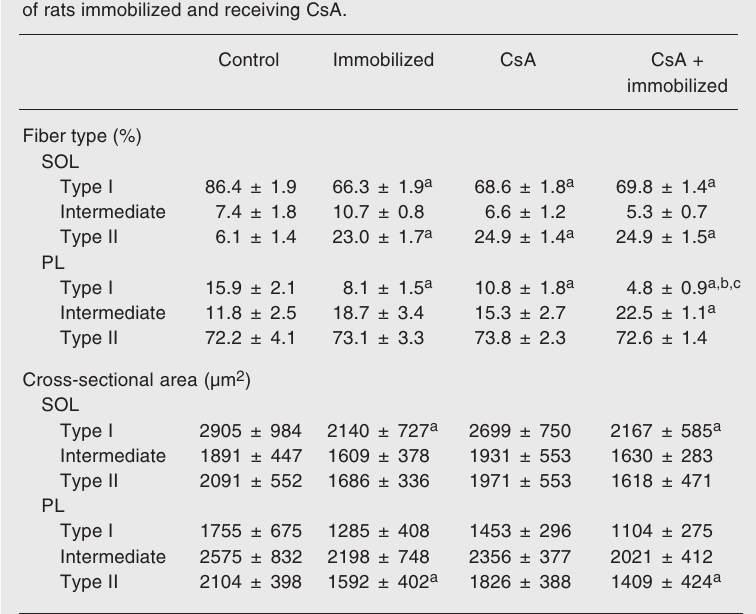
Table 2. Muscle fiber composition and cross-sectional area of soleus (SOL)